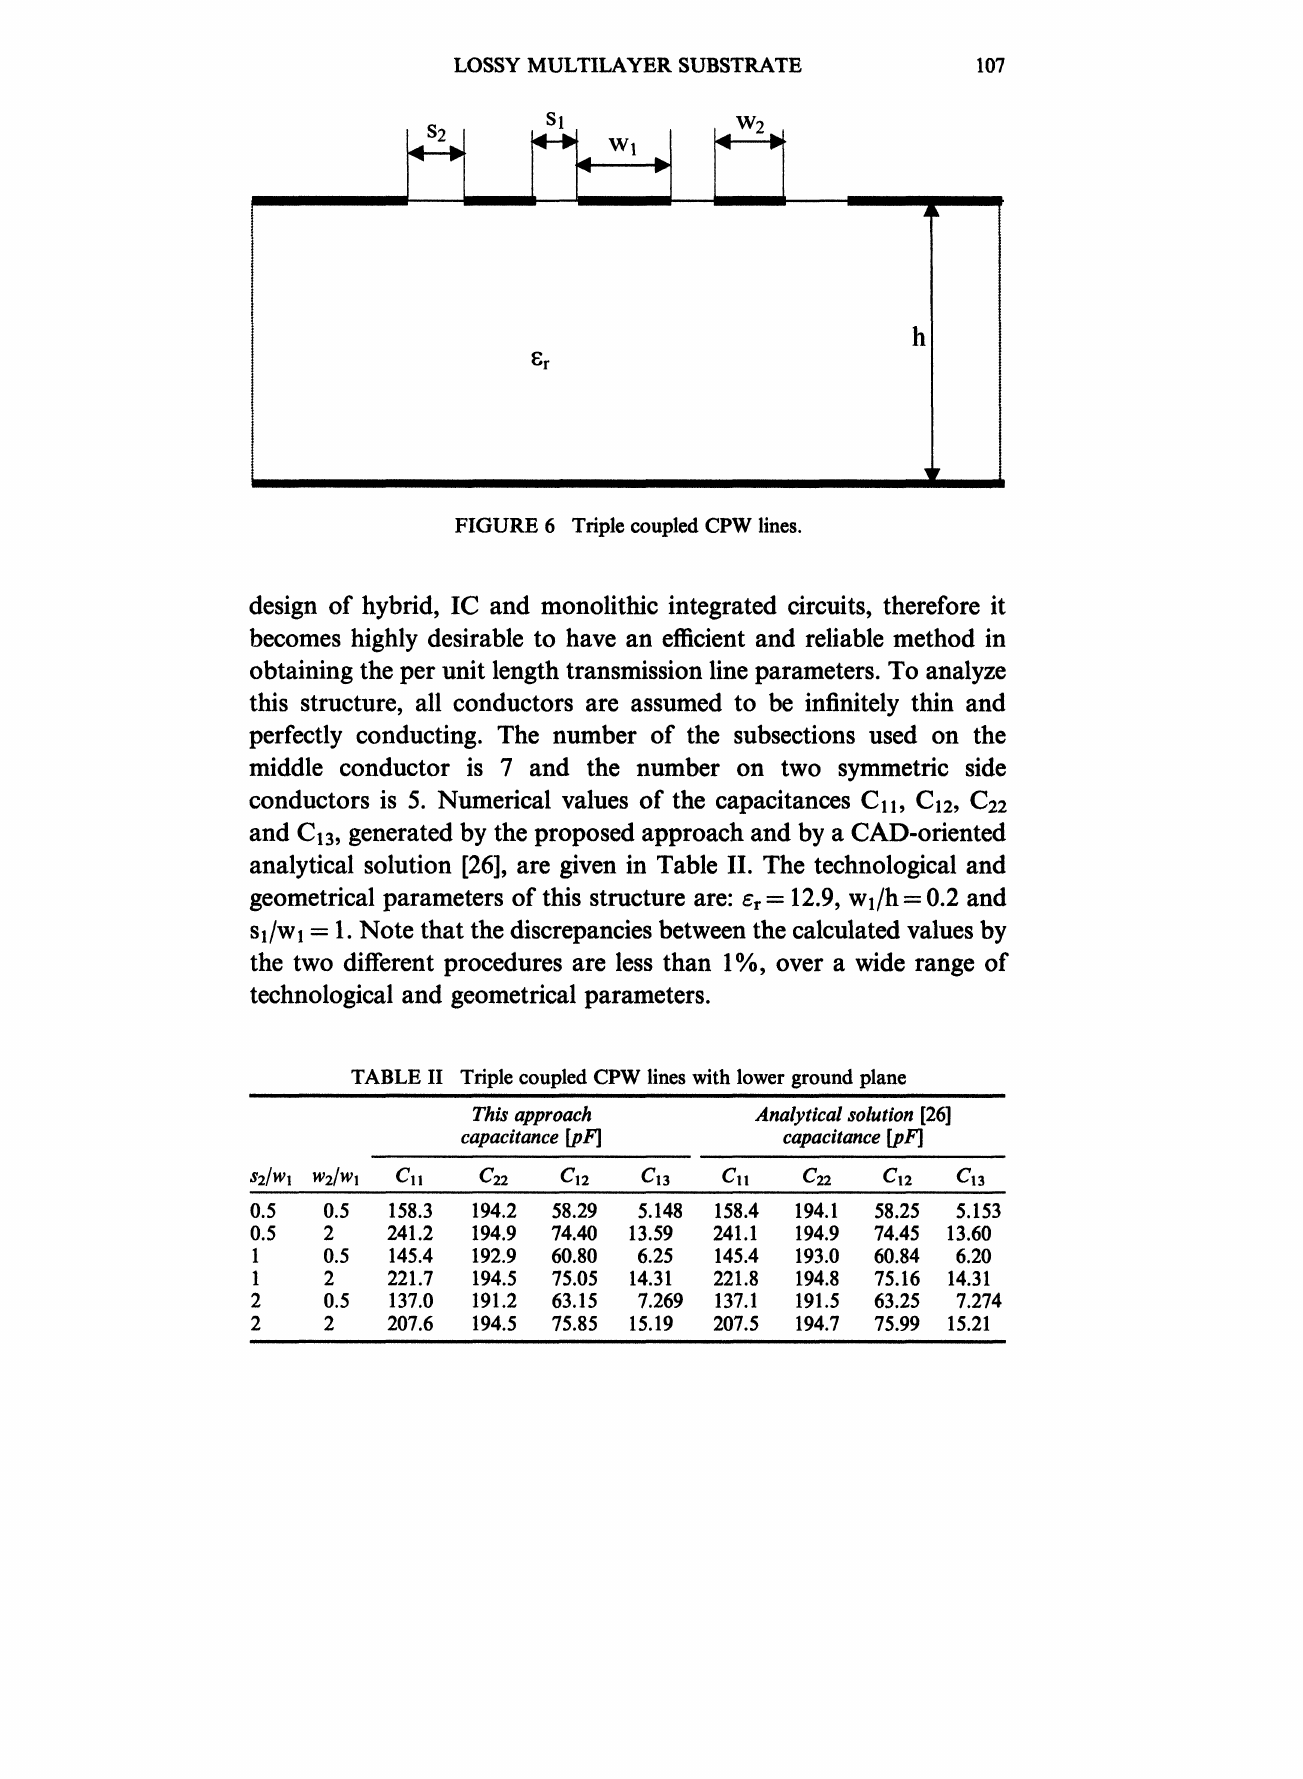
TABLE II Triple coupled CPW lines with lower ground